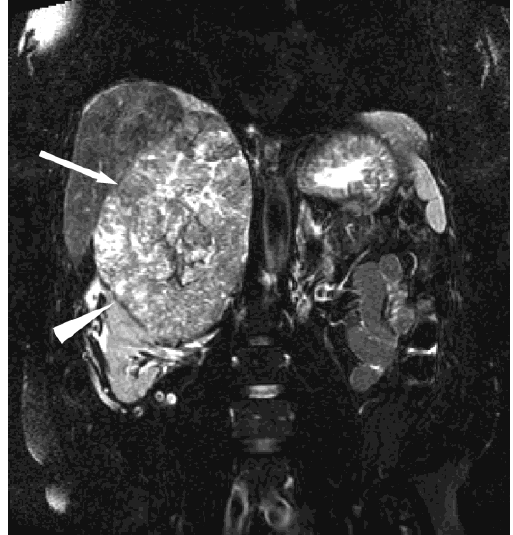
FIGURE 2. MRI demonstrating involvement of right kidney and liver. Arrowhead demonstrates tumor and kidney interface. Arrow demonstrates proximity/involvement of right